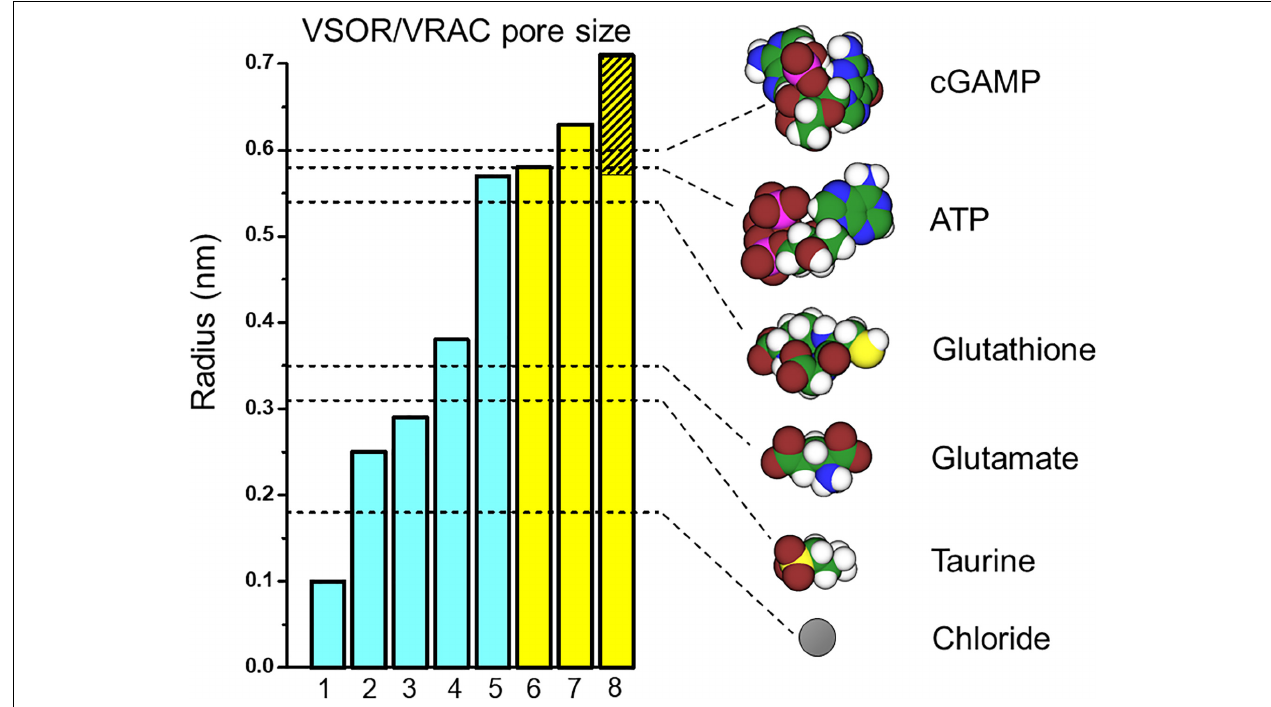
FIGURE 1 | VSOR/VRAC pore size and dimensions of the signaling molecules released via VSOR/VRAC. The pore radii depicted as the bar graphs were taken from: 1 – Kefauver et al., 2018; 2 – Kern et al., 2019; 3 – Deneka et al., 2018; 4 – Kasuya et al., 2018; 5 – Nakamura et al., 2020; 6 – Nilius et al., 1999; Nilius and Droogmans, 2003; 7 – Ternovsky et al., 2004; 8 – Droogmans et al., 1998, 1999. The values for bars #1 and #2 were deduced from the graphs of the pore radius plotted against the distance along the pore axis by the cited authors. Other values are as given by the cited authors. The hatched part of bar #8 indicates lower and upper limits given by the authors. Blue and yellow bars represent the radii structurally evaluated by cryo-EM studies for LRRC8A/D homohexamers and those functionally estimated for the native VSOR channel by electrophysiological studies, respectively. The unhydrated radii of the organic anions (shown as dashed lines) were calculated as a geometric mean of molecular dimensions produced using Molecular Modeling Pro computer software (Norgwyn Montgomery Software Inc., North Wales, PA, United States). Values for ATP and glutamate were reported previously (Sabirov and Okada, 2005). Color coding: C, green; H, white; O, red; N, blue; P, purple; S, yellow; Cl, gray.